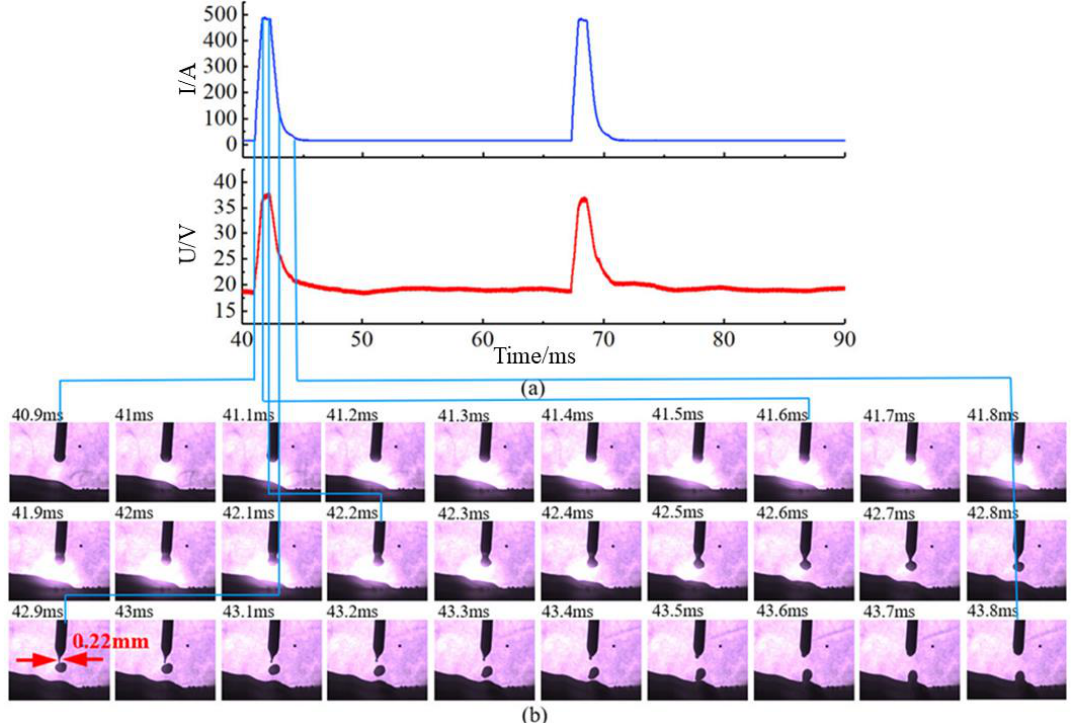
Figure 6. P-GMAW current and voltage signal and arc and droplet transition behavior photographs ( I p = 485 A): ( a ) current and voltage signal; ( b ) synchronous photographs.